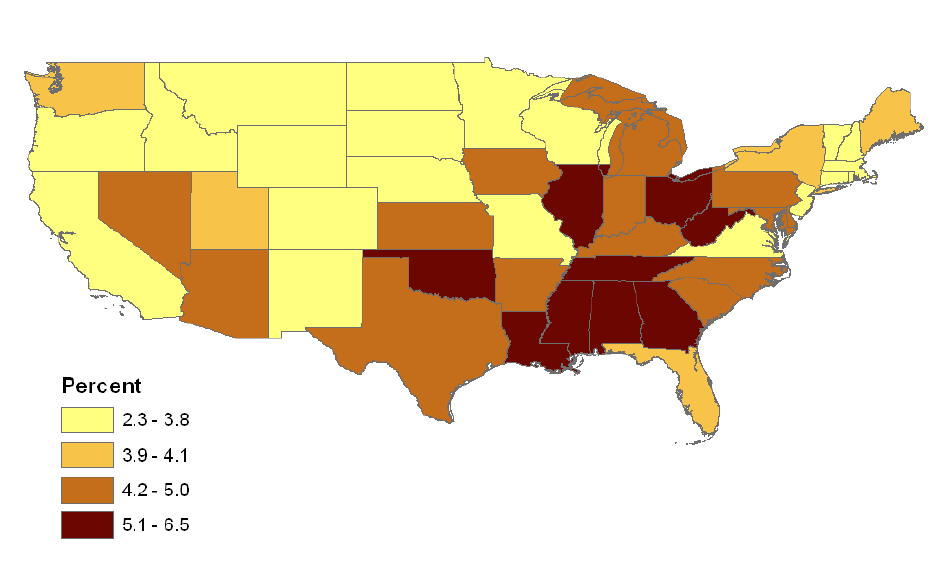
Figure 1 . Percent of adults both diabetic & obese, BRFSS